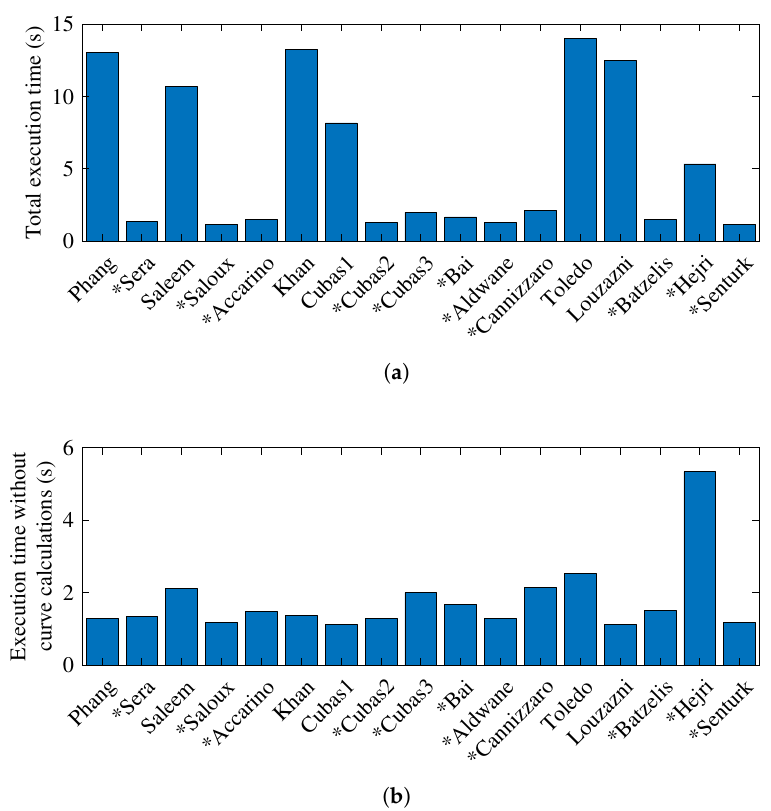
Figure 6. Computational cost of the 17 methods. ( a ) Total execution time. ( b ) Execution time excluding curve